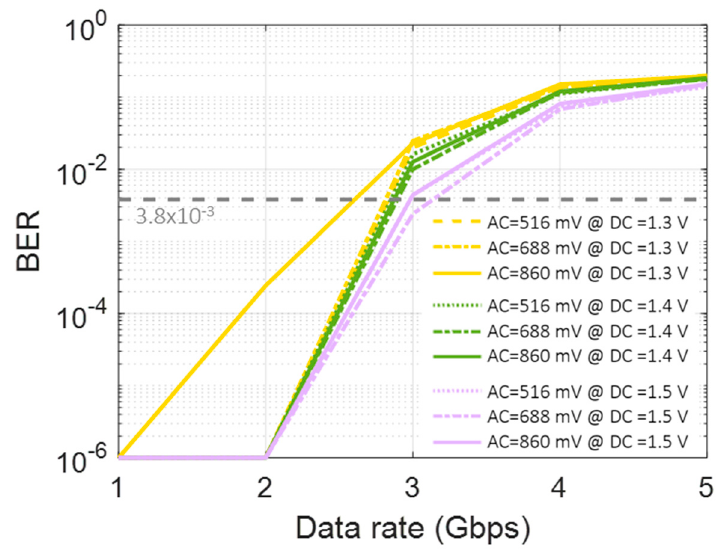
Figure 7. BER performance according to different AC and DC values.